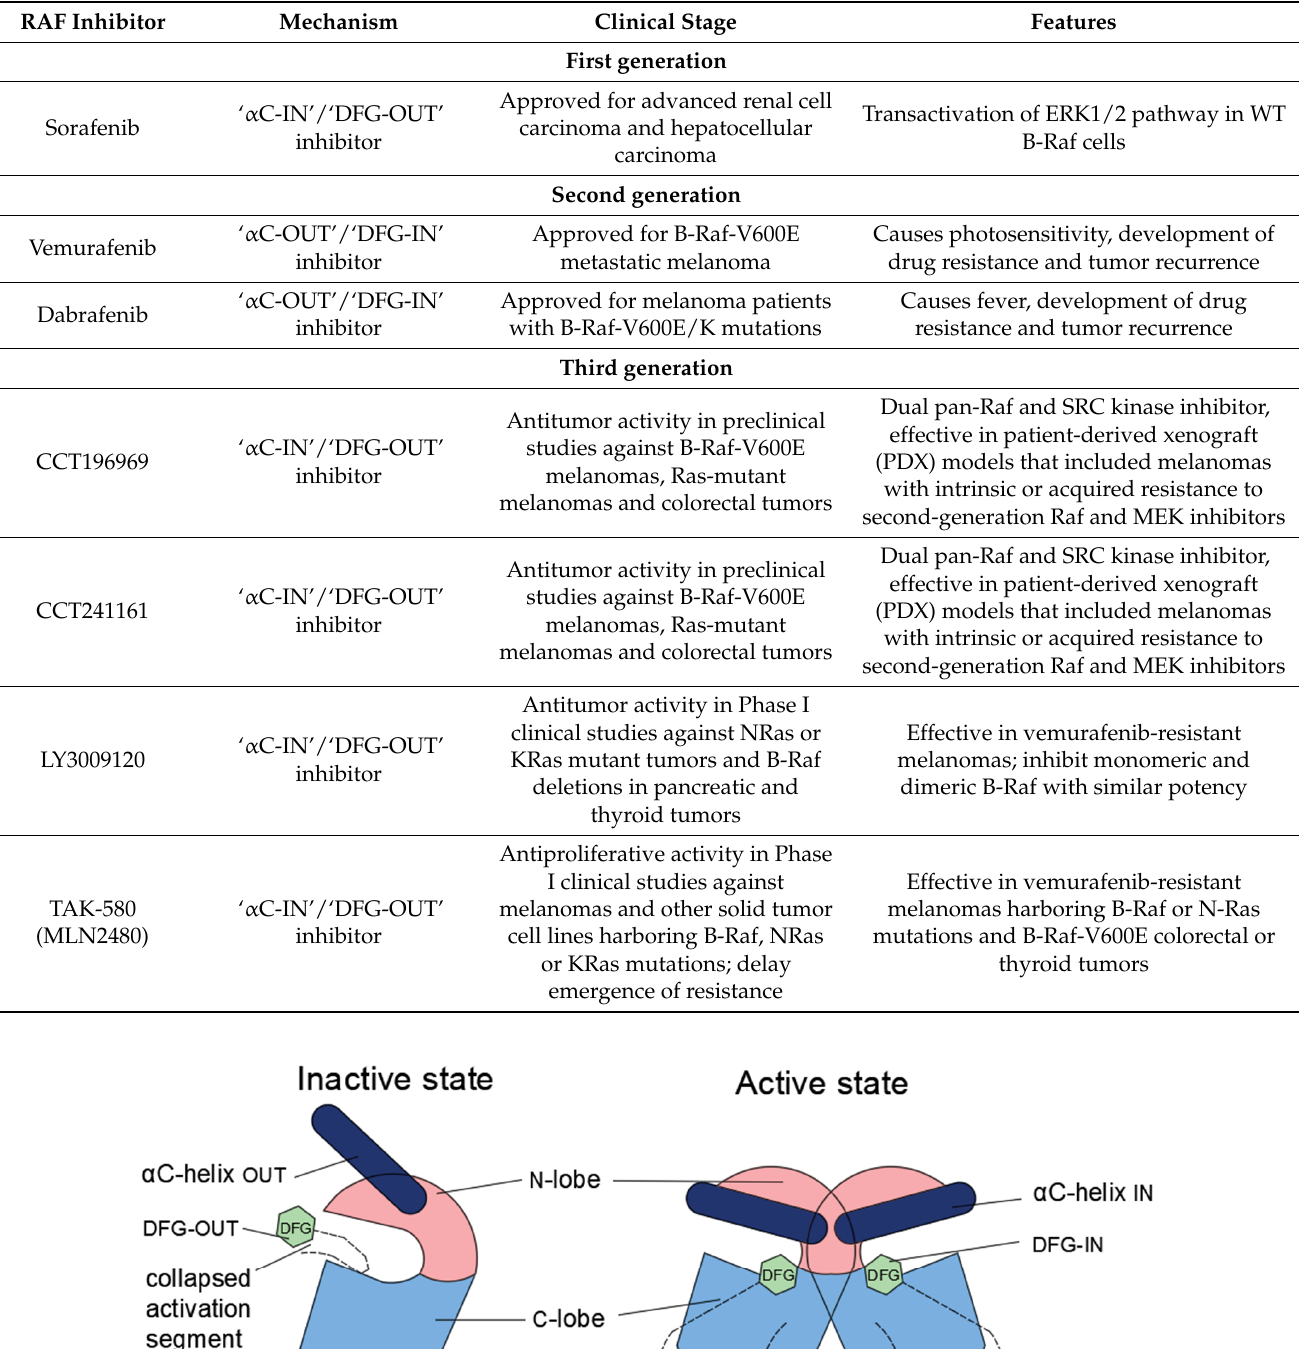
Table 2. B-Raf inhibitors in cancer therapy.